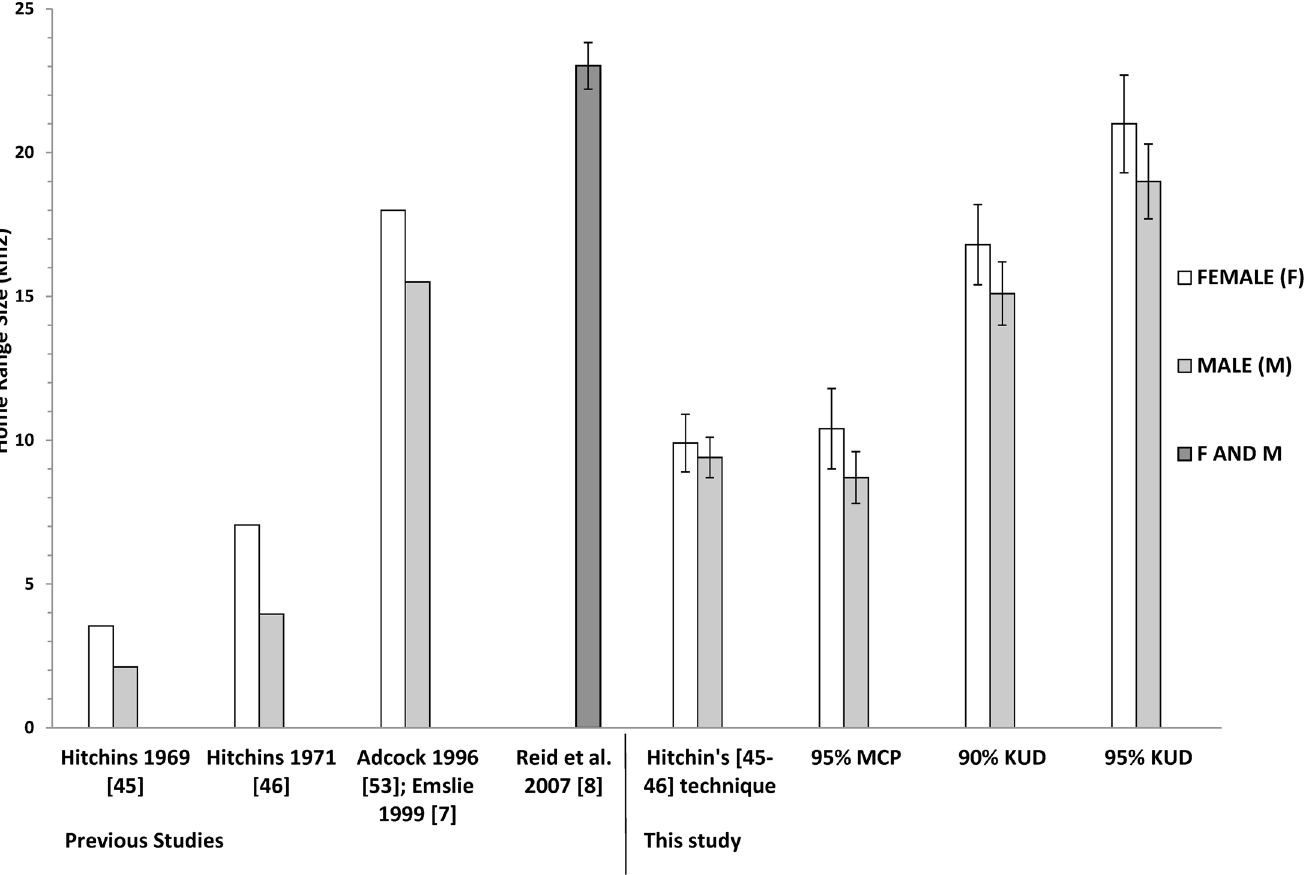
Fig 6. Historical sequence of home range estimates for black rhino Diceros bicornis minor in Hluhluwe-iMfolozi Park, South Africa. Included for comparison are the four home range estimates from this study where different analysis techniques were used (i.e., Hitchin ’ s [45 – 46] visual approximation technique, 95% MCP ’ s, 90% and 95% kernels). Standard error is included for home range estimates where possible. Note that the unshaded (white) bars represents average range sizes for female rhino, whereas the shaded (light grey) bar represents male averages. The darker shaded bar (dark grey) represents the home range average for males and females combined, as Reid et al. [8] did not report estimates for the different sexes.